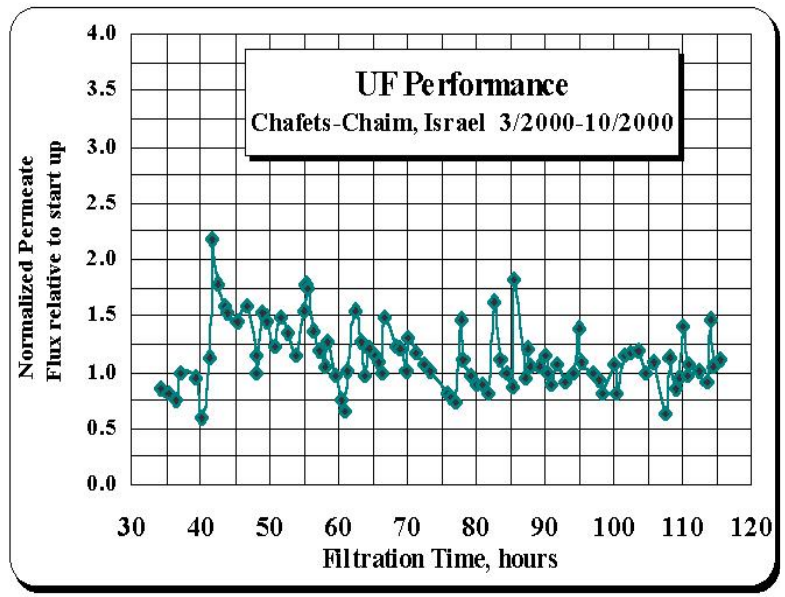
Figure 2. Normalized UF permeate flow relative to start up.